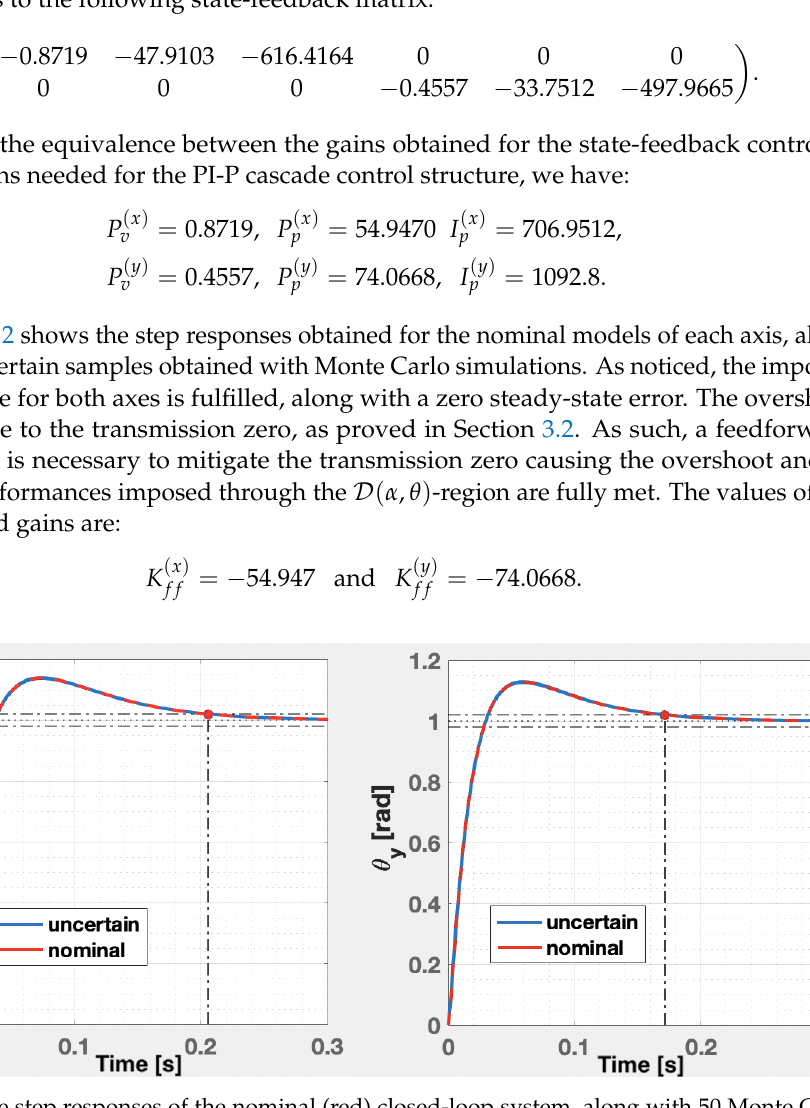
Figure 2. The step responses of the nominal (red) closed-loop system, along with 50 Monte Carlo simulations (blue) for X axis ( left ) and Y axis ( right ), without considering the feedforward